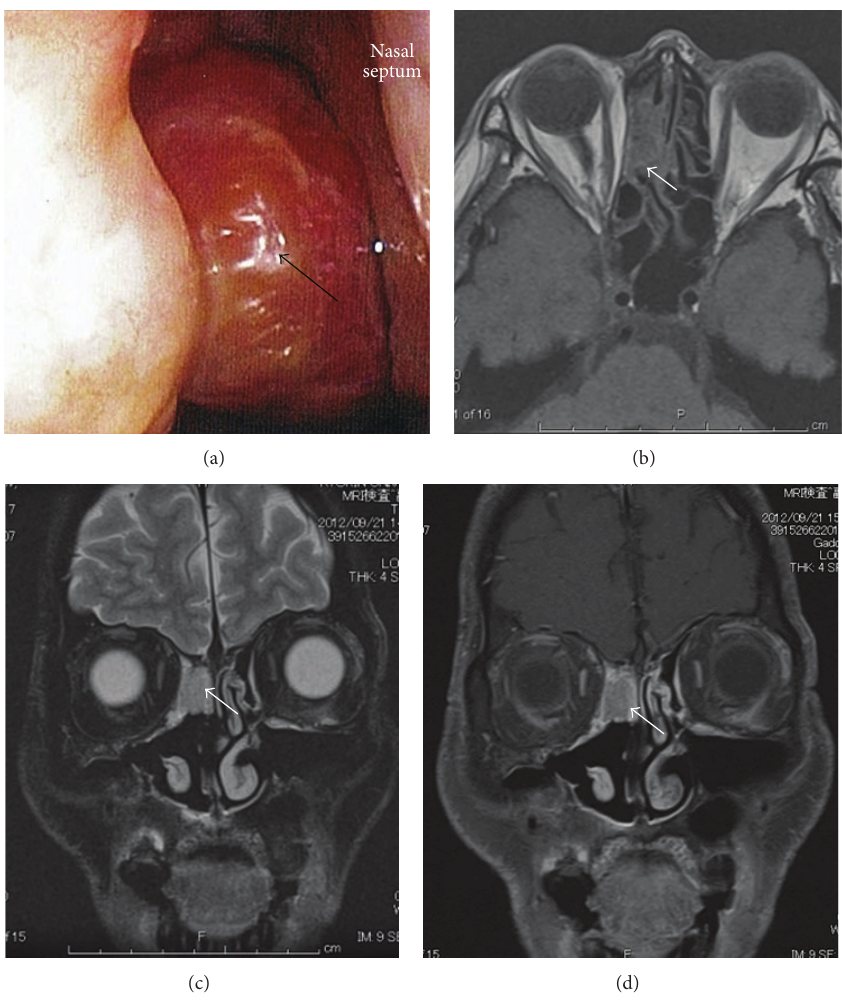
Figure 5: Preoperative local finding and MRI in case 2. (a) Tumor in the right nasal cavity showing a low-intensity area (black arrow). (b) T1-weighted axial image showing a slightly high-intensity area (white arrow). (c) T2-weighted coronal image (white arrow). (d) T1-weighted coronal image (gadolinium+) shows some enhancement within the lesion (white